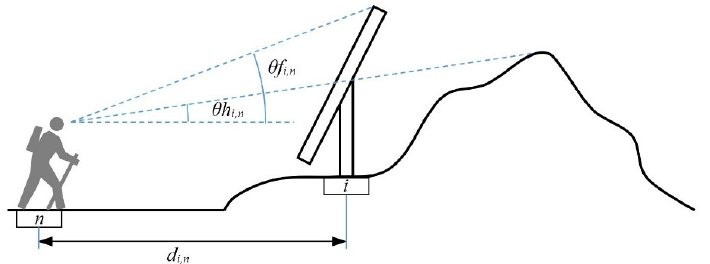
Figure 1. Lines of sight connecting the observer, in node n, to the PV facility and to the horizon. The 𝐼𝑠𝑘 (cid:3036) , (cid:3041) index can take values between 0 and 1, and represents the value per